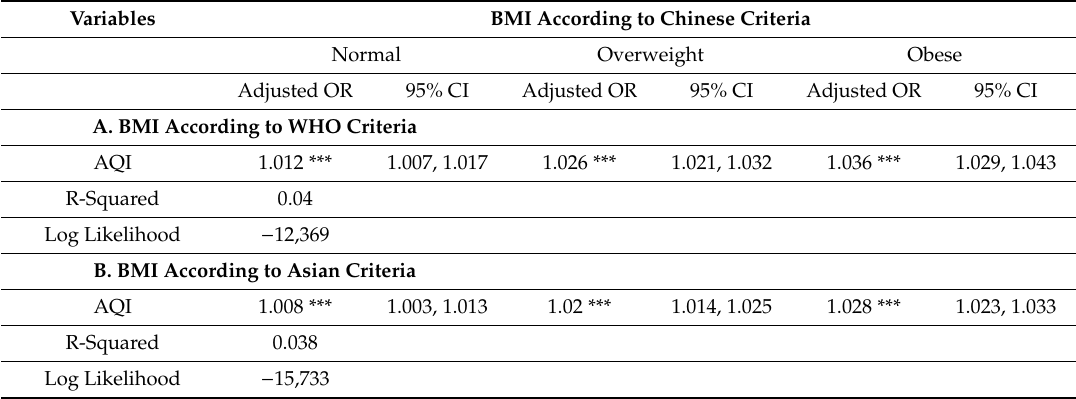
Table 4. E ff ect of Air Quality Index (AQI) on Body Mass Index (BMI): BMI according to WHO and Asian